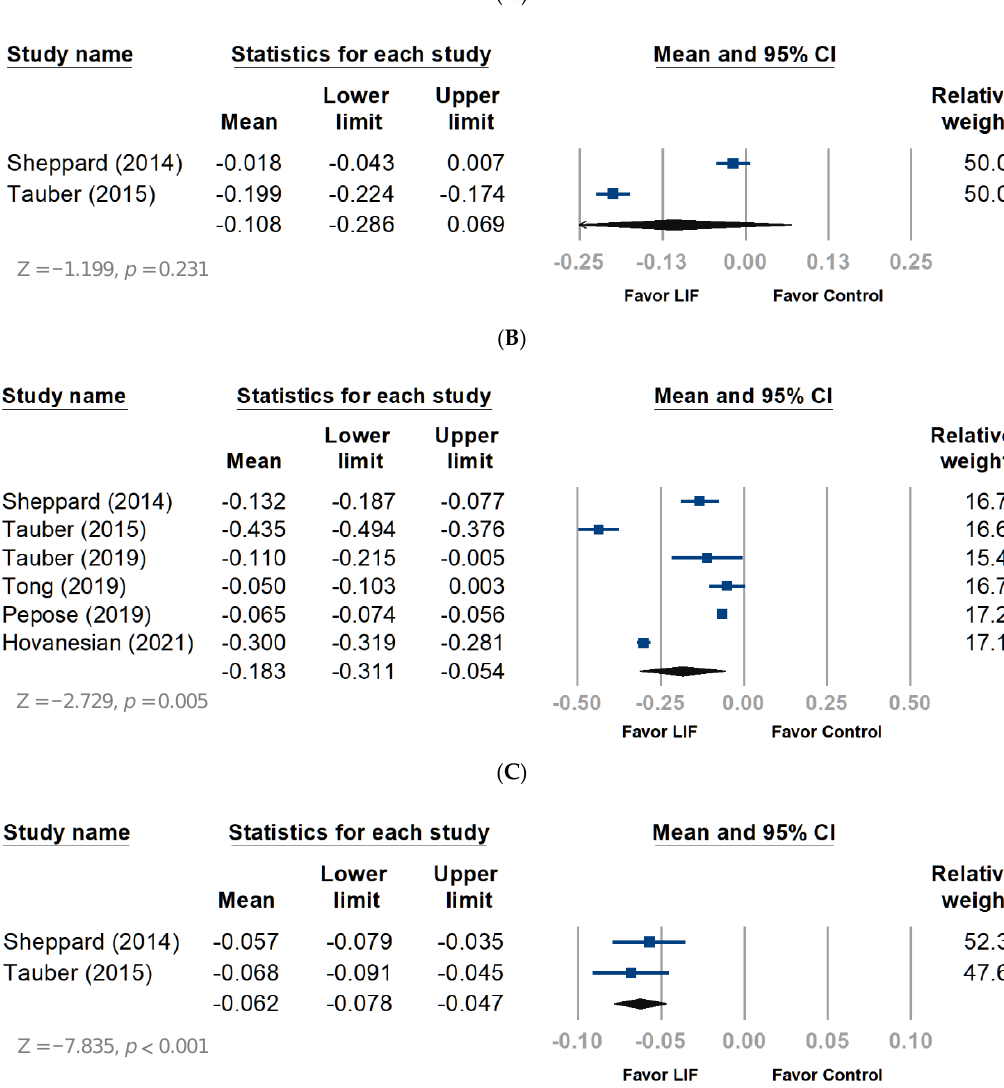
Figure 2. Risk of bias of included studies. ( A ) Risk of bias of included randomized controlled trials. ( B ) Risk of bias of included nonrandomized studies. A green dot denotes the low risk of bias, yellow for unclear risk of bias, and red for high risk of bias [9 – 18].